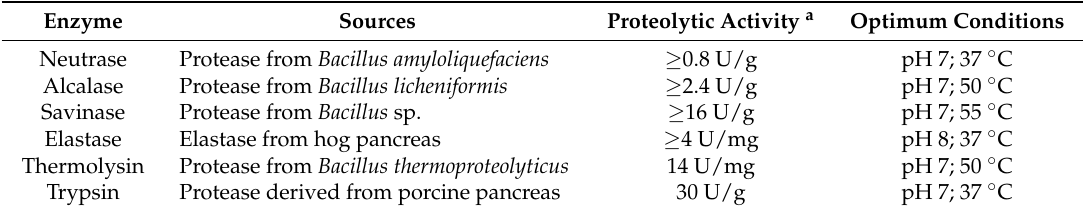
Table 1. The enzymes applied in high hydrostatic pressure combined with enzymatic hydrolysis (HHP–EH) and atmospheric hydrolysis, and the operational conditions.